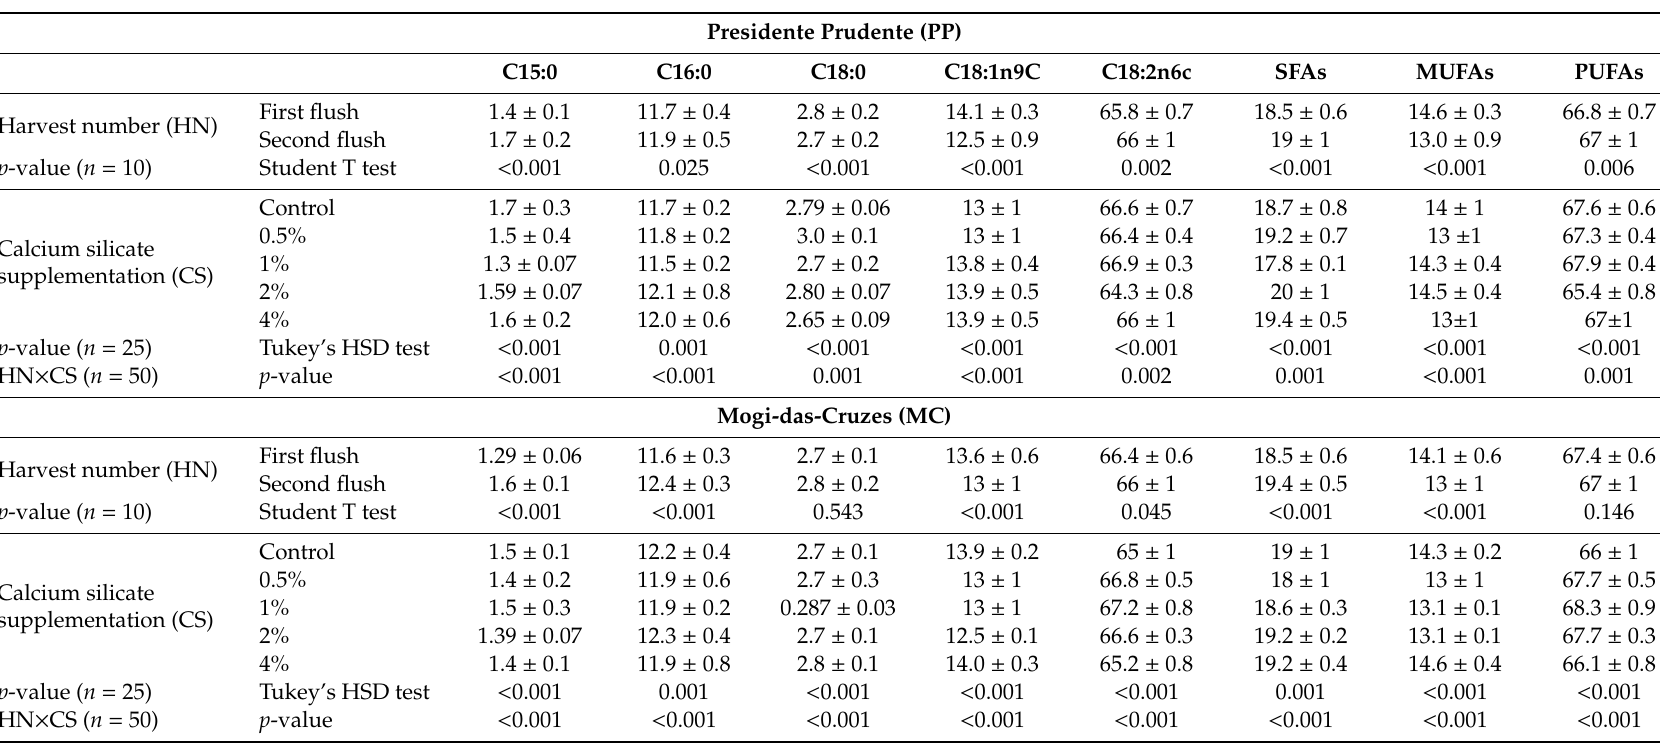
Table 3. Fatty acids detected through GC-FID from the two mushroom strains across the two harvest periods and CS supplementation, expressed in relative percentage of themselves. Only fatty acids with a relative above 1% are tabled, although others were identified and